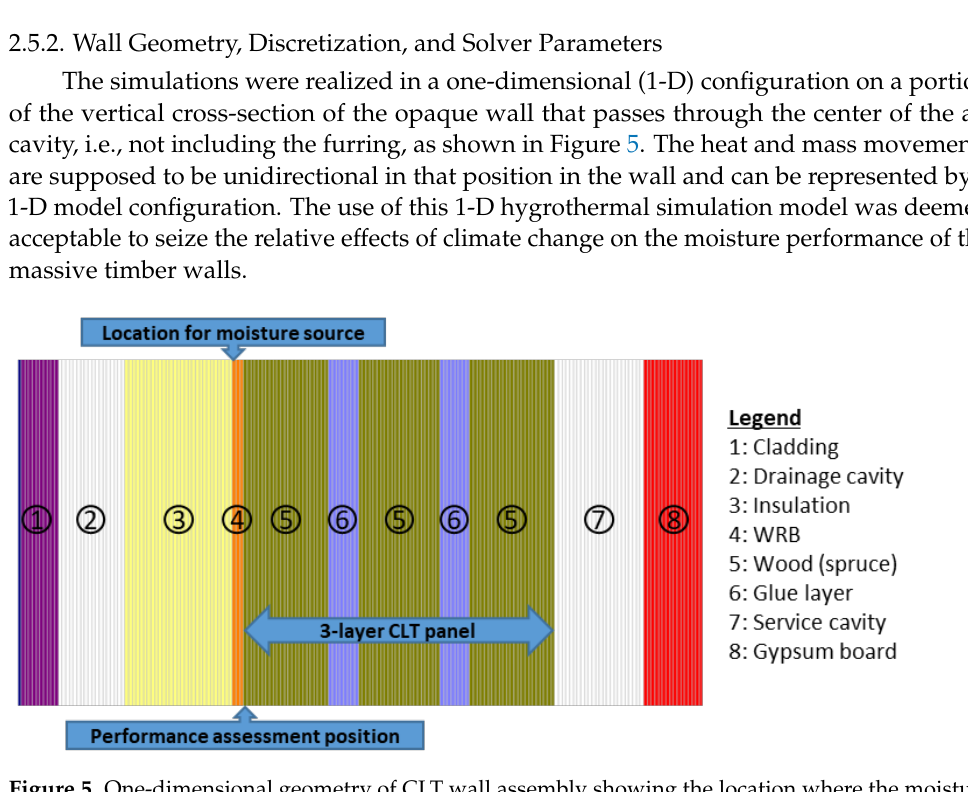
Figure 5. One-dimensional geometry of CLT wall assembly showing the location where the moisture source was applied (outer grid of weather-resistive barrier—WRB), the critical position for perfor- mance evaluation (outer grid of CLT panel), and the meshing. Different layers are colored for clarity. Grids are not to scale.